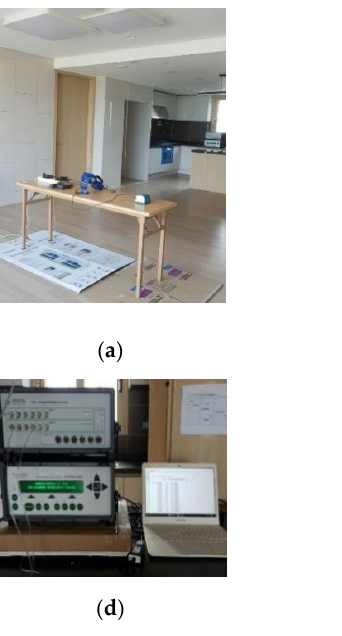
Figure 3. Measurement of ( a ) indoor particle concentration, ( b ) outdoor–particle concentration, ( c ) ventilation flow rate, ( d ) air exchange rate, ( e ) particle concentration on outlet side of ventilation system, and ( f ) particle concentration on outlet side of filtration system.